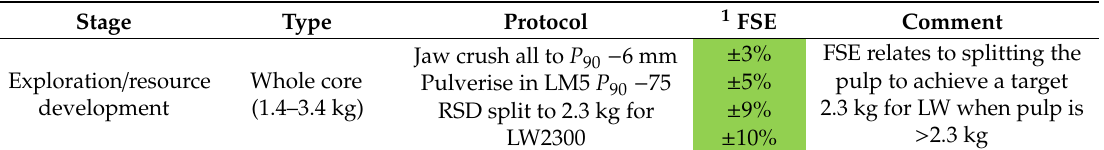
Table 12. FSE for nominal drill core protocol at BCOG across d 95Au scenarios (Table 6) for Castlemaine Goldfields Pty Ltd (CGT) (post-2014). FSE calculations assume the presence of coarse gold in the pulp.